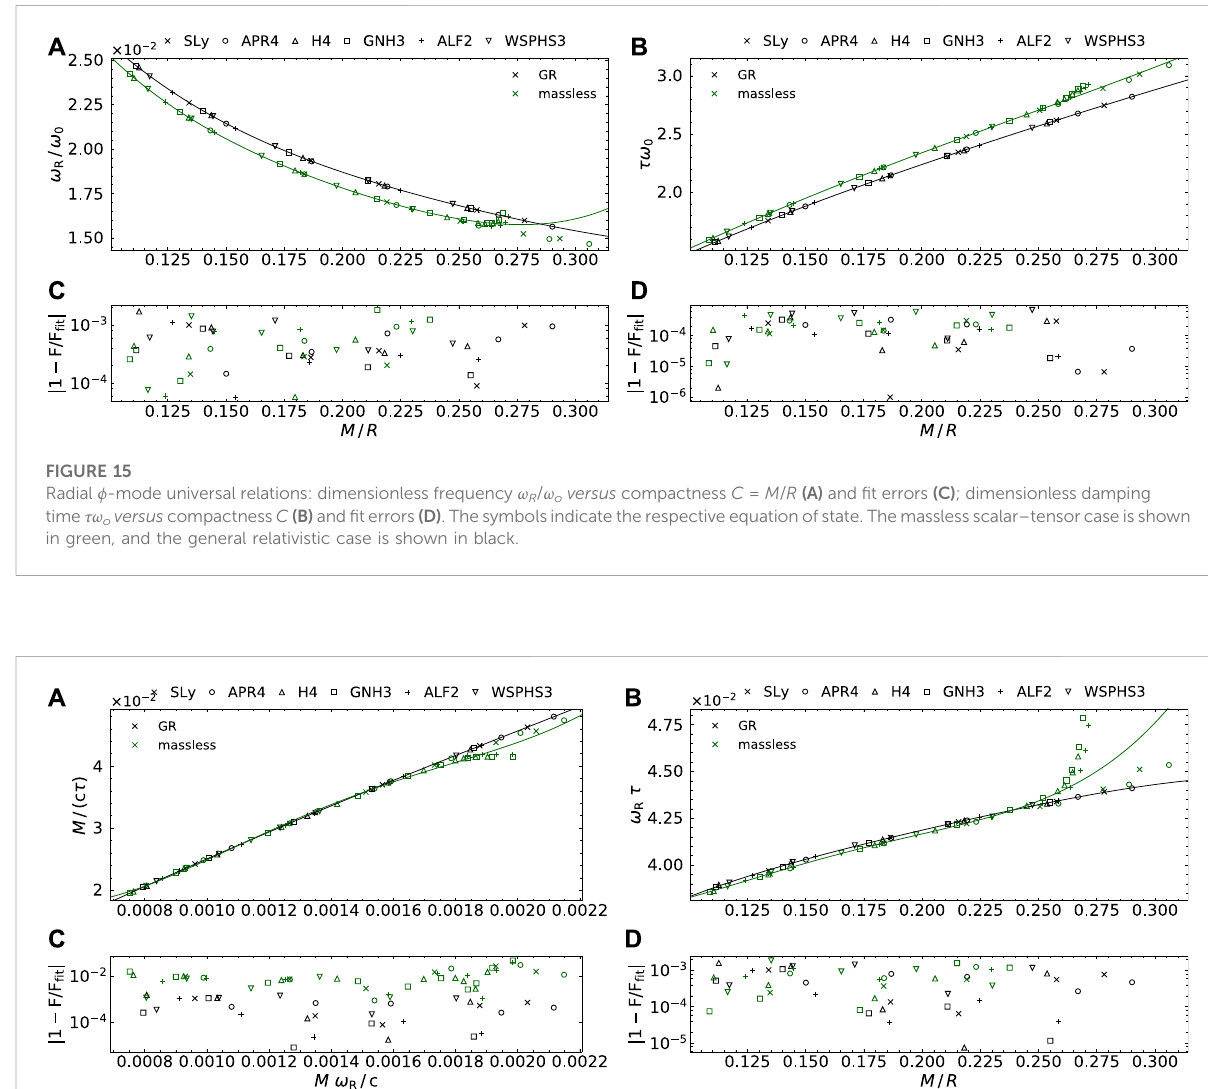
FIGURE 16 Radial ϕ -mode universal relations: dimensionless inverse damping time M /( c τ ) versus dimensionless frequency M ω R / c (A) and fi t errors (C) ; dimensionlessproduct ω R τ offrequencyanddampingtime versus compactness C (B) and fi terrors (D) .Thesymbolsindicatetherespectiveequation of state. The massless scalar – tensor case is shown in green, and the general relativistic case is shown in